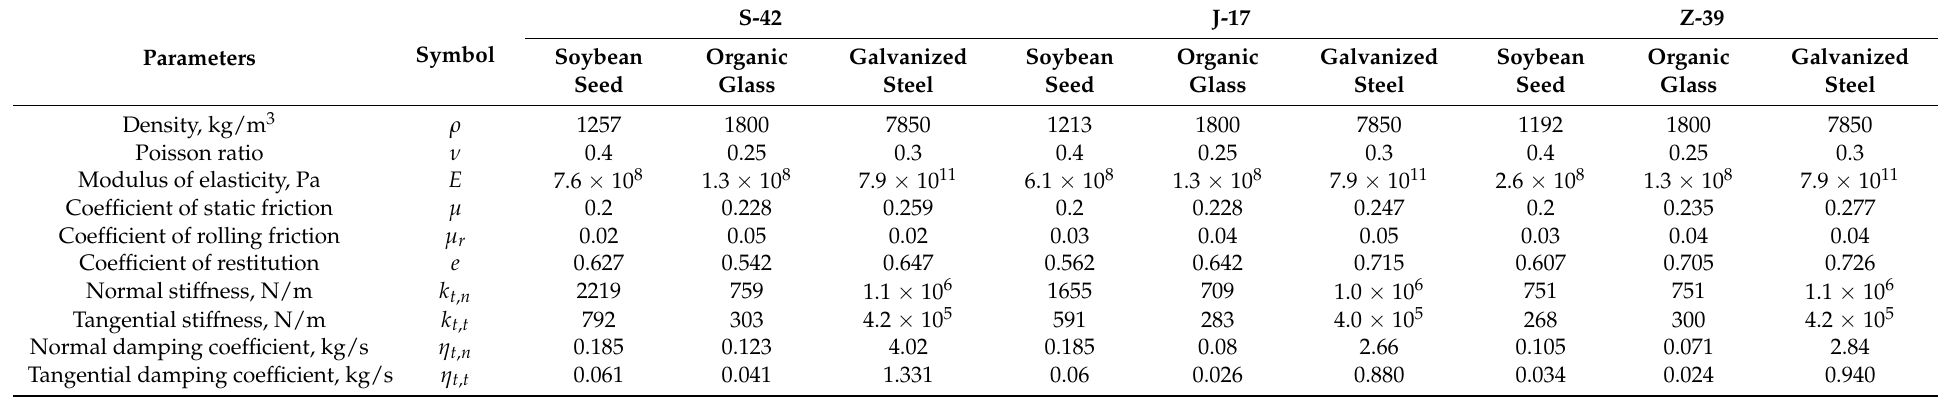
Table 2. Parameters used in the